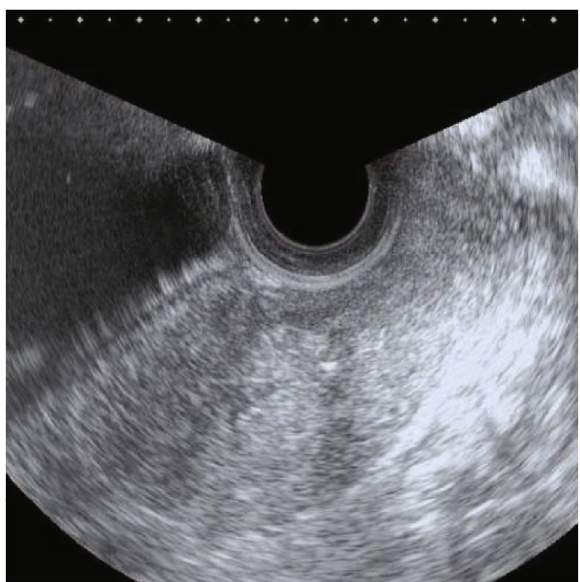
Figure 1: Ultrasound view of the uterus 1 month after childbirth. The longitudinal length of the uterus is 8.2cm. No abnormal structures are visible in either the uterine body or the